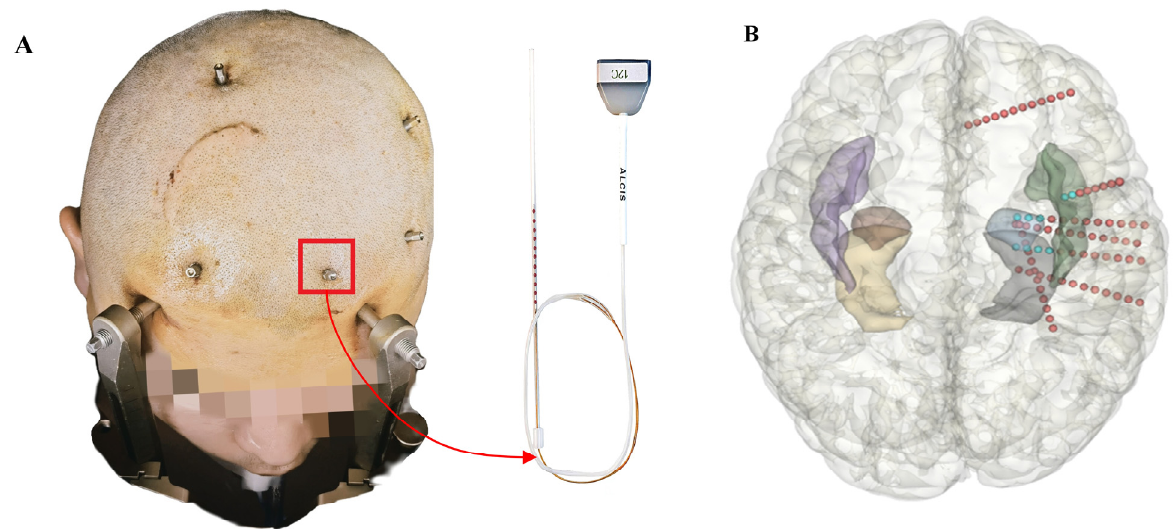
Figure 1. ( A ) is an intraoperative photo of electrodes after implantation, and the red frame contains a single electrode. Right side shows details of an SEEG electrode. The red points on the SEEG electrode are contacts. ( B ) depicts SEEG electrodes implanted in a whole 3D brain.